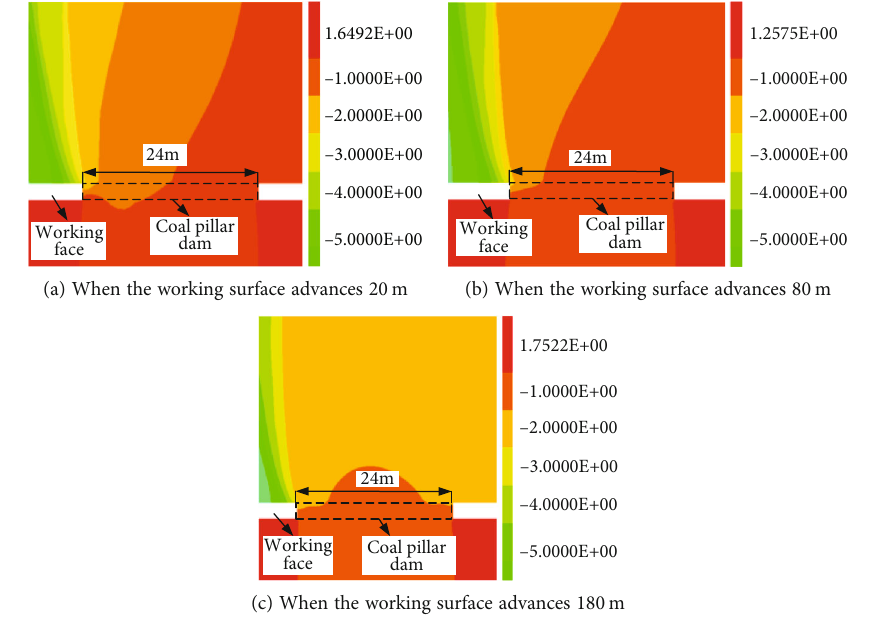
Figure 5: Deformation cloud diagram during